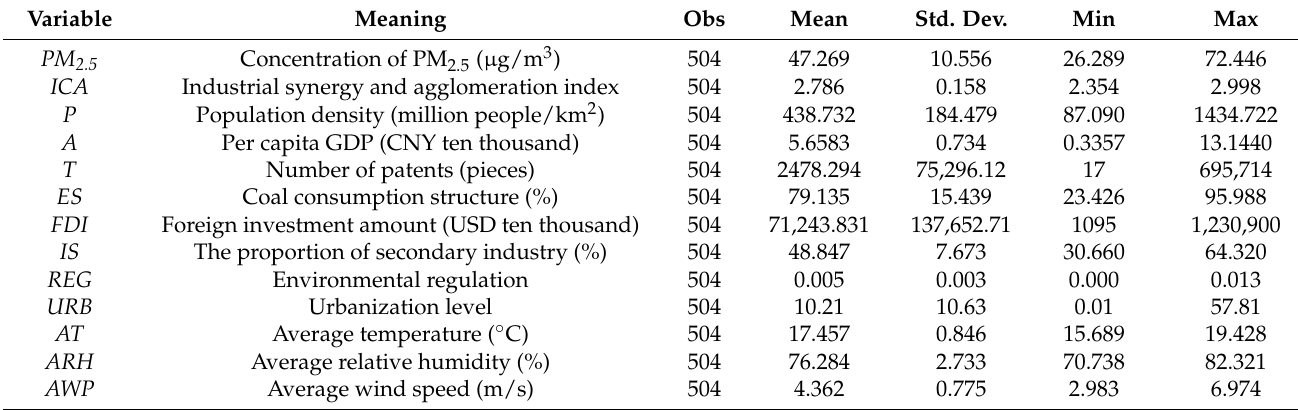
Table 1. Variables in the empirical